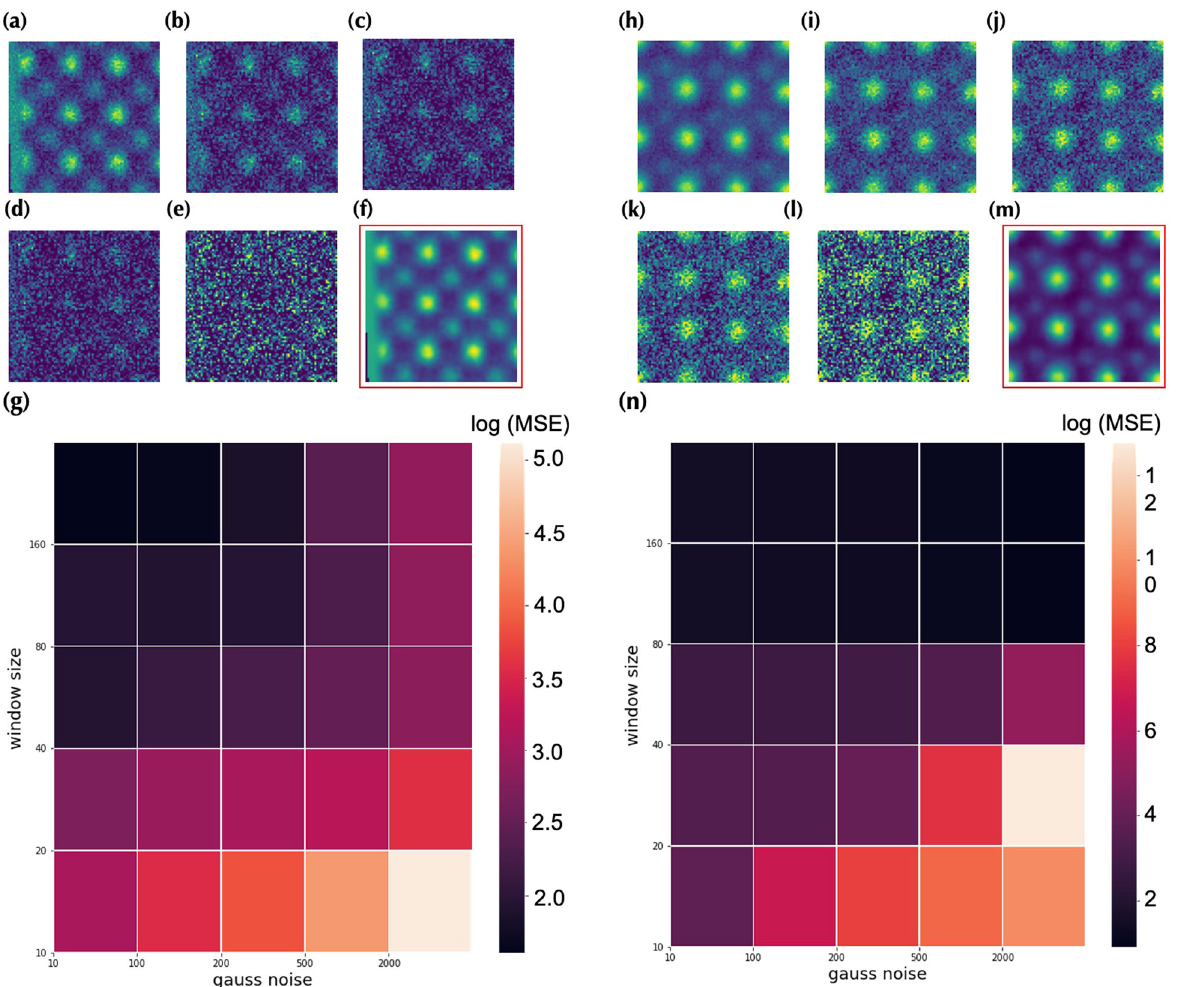
Fig. 7 Noise sensitivity/performance of DCNNs. Figure shows the analyses for different window sizes (10, 20, 40, 80, and 160 pixels) when various levels of gauss noise (10, 100, 200, 500, 2000 in arb. units) are added to the dataset. Selective sub-images for window size of 80 with various gauss-noises added are shown in a – e and h – l for NC and C. Reference sub-images are represented by f and m corresponding to sub- images generated with no added noise with the same window size. DCNNs trained with a stack of sub-images with no noise added are utilized to predict on this group of noisy sub-images. MSE values for each window size-noise combination are plotted as heatmaps in a and b for one image for both NC and C,